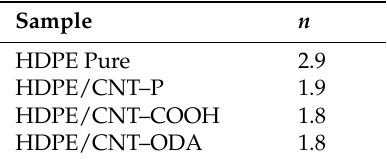
Table 3. Avrami coefficient “ n ” of the empirical kinetic JMA model for pure HDPE and HDPE/CNT nanocomposites.